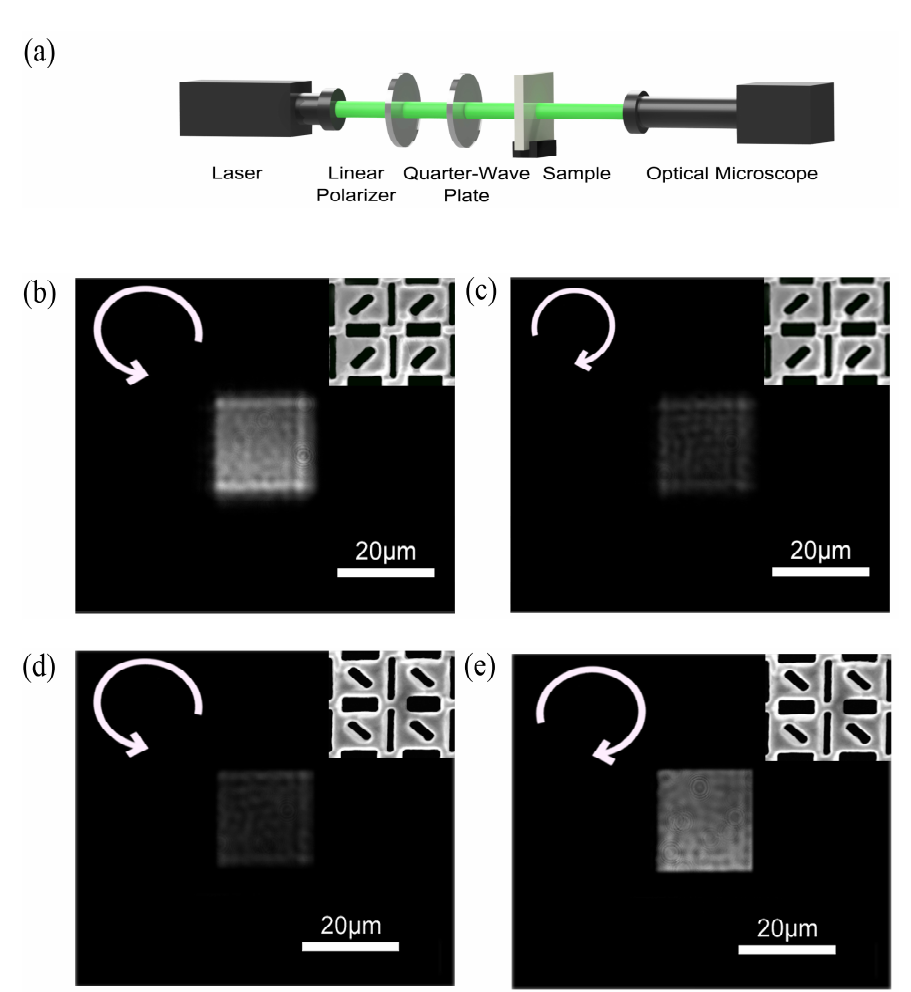
Figure 9. Performance testing. ( a ) Experimental setup for performance verification of the SCPMs. ( b , c ) Grayscale images of the sample of the left-handed structures under the left-handed and right- handed circularly polarized light. ( d , e ) Grayscale images of the sample of the right-handed structures under the left-handed and right-handed circularly polarized light. The handedness of the circularly polarized light is defined from the view of the receiver (right-handedness corresponds to a clockwise rotation, and left-handedness corresponds to an anti-clockwise rotation). First, the target area of the experimentally acquired images are divided into 400 re ‐ gions according to 10 × 10 pixels. Then, the circular polarization extinction ratio and cir ‐ cular polarization transmittance difference of the corresponding regions are counted. The normal distributions of the circular polarization extinction ratio and circular polarization transmittance difference across 400 regions are given in Figure 10a,b. The horizontal co ‐ ordinates correspond to the peaks of the normal distribution representing the average val ‐ ues of the circular polarization transmittance difference and circular polarization extinc ‐ tion ratio, which reached 6.02 and 0.25, respectively. We extract pixel values of the sample grayscale image corresponding to 80% of the area and obtain a result in which the CPER of the SCPMs reaches 6.